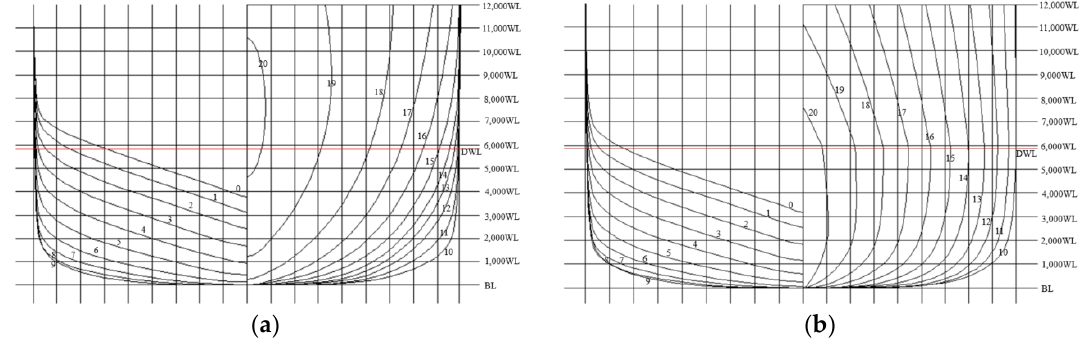
Figure 5. Sketches of the section lines for XB1 and XW1 models; ( a ) XB1 ( b ) XW1. Table 4. Main dimensions of ship models.